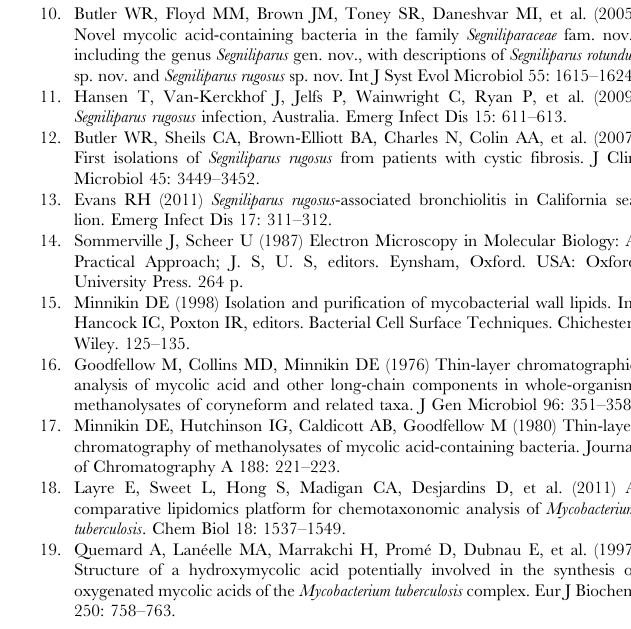
Figure S3 Positive-ion mode of Q-Tof mass spectrometry of MAMEs derived from Segniliparus rotundus that were separated and recovered from 1D TLC as high, middle or low bands, as illustrated in Fig. 2a. Due to lack of complete separation of the middle and high migrating doublet observed on TLC, the high migrating band contains ions also seen in the middle migrating band. Only ammonium adducts were labeled for high and middle bands. The ammonium or proton adducts detected in the low migrating band were labeled as indicated. (TIF) Figure S4 Positive-ion mode Q-Tof mass spectrometry of MAMEs derived from Segniliparus rugosus were separated and recovered from 1D TLC as high or middle bands as illustrated in Fig. 2a. Only ammonium adducts were labeled. (TIF) Figure S5 S. rotundus MAMEs isolated from the 1D TLC high migrating band and middle migrating band were analyzed by 1H NMR spectroscopy. As indicated in Fig. S3, these are enriched for chain length-based classes, but are not fully purified based on chain length. However, key aspects of the spectra are recapitulated in the more fully purifiable compounds shown in Fig. 5. (TIF)